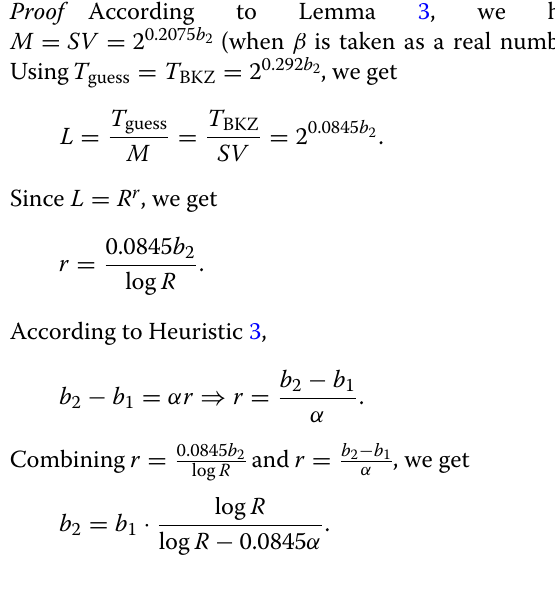
0.0845 b 2 log R =